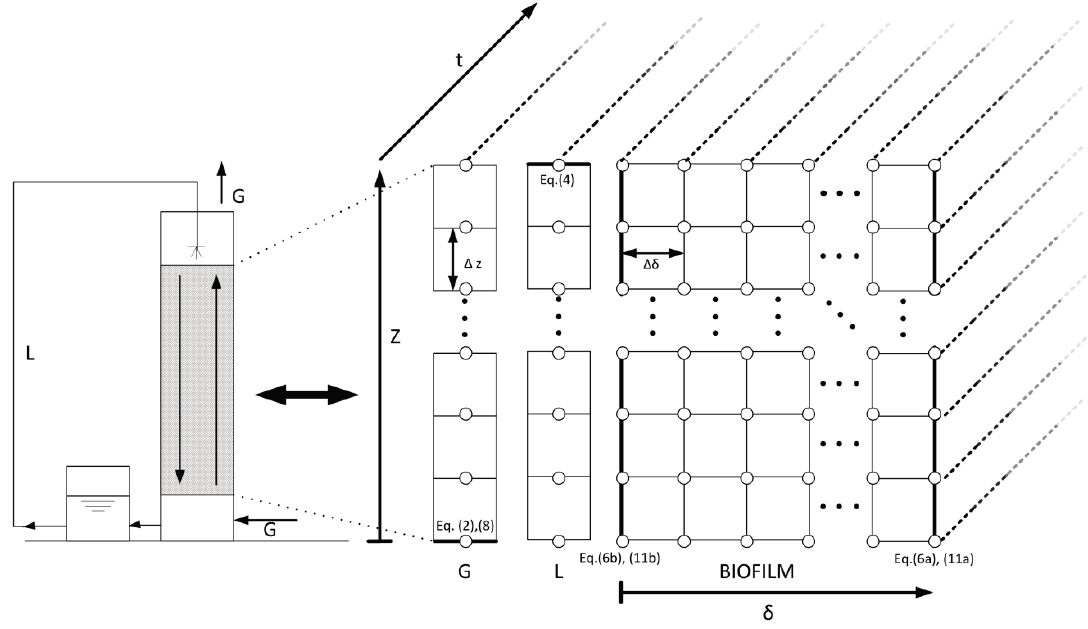
Figure 1. Conceptual scheme of the BTF and model derivation. Bold lines indicate the boundary conditions. Eq. means